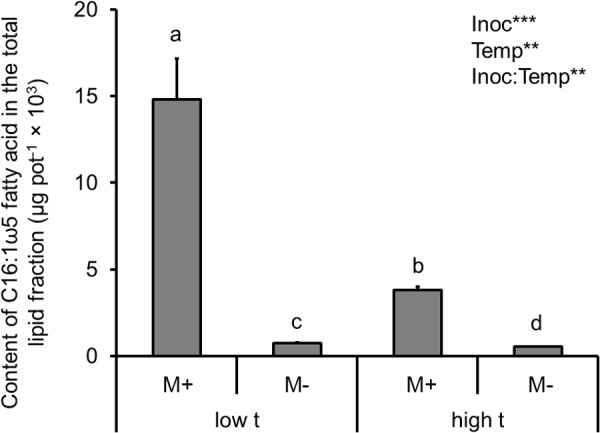
Content of the AMF-specific fatty acid (C16:1ω5) in the total lipids extracted from the root and substrate samples, summed together per cultivation containers planted with both of the Panicum species (i.e., roots of both C3- and C4-Panicum, substrate in both of the plant compartments and the RFC), as affected by mycorrhizal inoculation (M+, mycorrhizal inoculum added; M-, non-mycorrhizal control) and cultivation temperature (low t, 25°C during daytime; high t, 36°C during daytime). Mean values ± standard errors are shown (n = 4 for M+ high t treatment, n = 3 for all the other treatments). Significances of inoculation (Inoc), cultivation temperature (Temp), and their interaction are indicated (factors with p ≥ 0.05 are not shown, ∗∗∗p < 0.001, ∗∗0.001 ≤ p < 0.01). Bars with different letters above mean significant differences at p = 0.05. Different letters at the individual bars indicate significant differences between the means at p < 0.05.